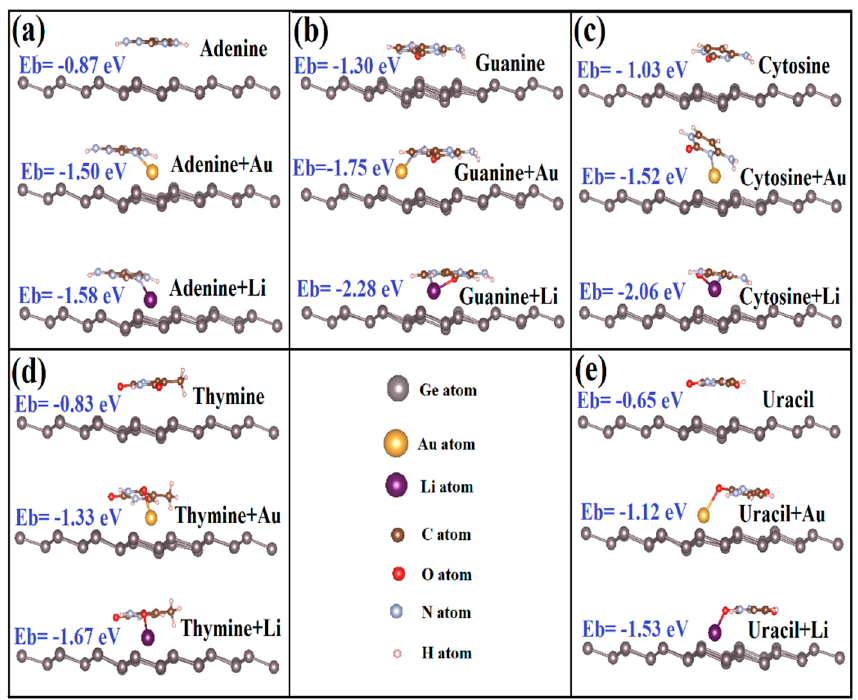
Figure 4. Optimized geometric structures and binding energies of nucleobases on bare and Li/Au- supported germanene. ( a ) Adenine, ( b ) Guanine, ( c ) Cytosine, ( d ) Thymine, and ( e ) Uracil.